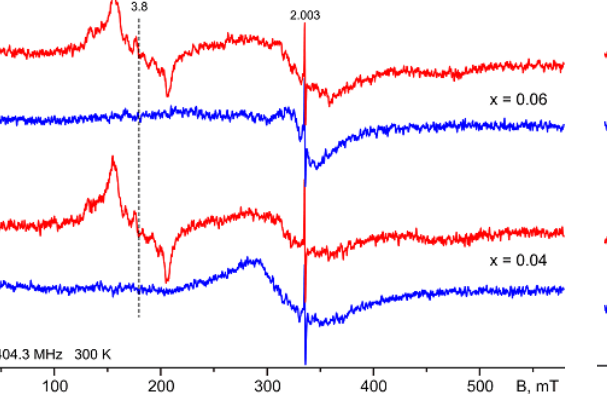
Figure 8: ESR spectra of BiNb 1− x Mn x O 4− δ (x=0.04 and 0.06) solid solution samples of triclinic (red, 1100 ∘ C) and of orthorhombic (blue, 750 ∘ C) modifications. Reference sample line with g =2.0032.